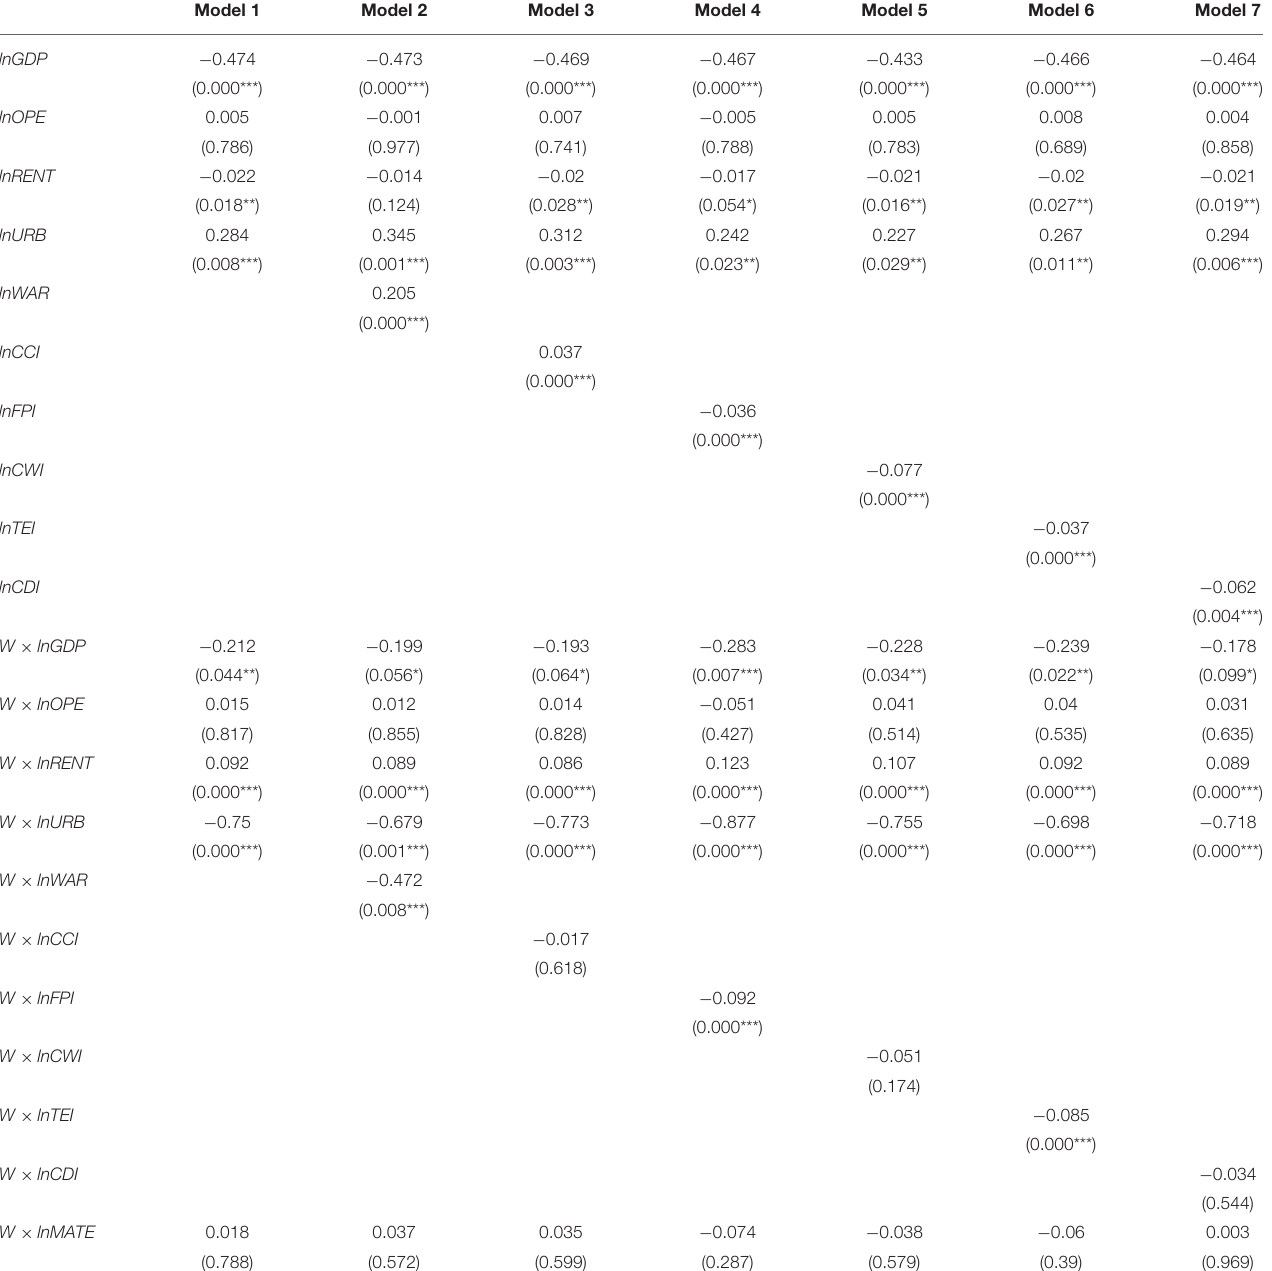
TABLE 5 | Estimation results for Equation